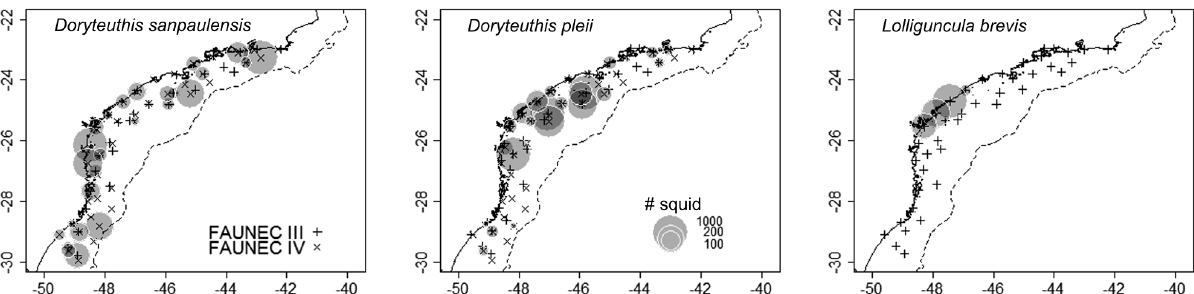
Figure 2. Maps of FAUNEC surveys from where squid where obtained. Abundance data were log-transformed for better visualization. Latitudes and longitudes are decimal transformed. The 200 m isobath is showed (dashed line). Electrodeless Induction Salinometer (model S/N 21705).